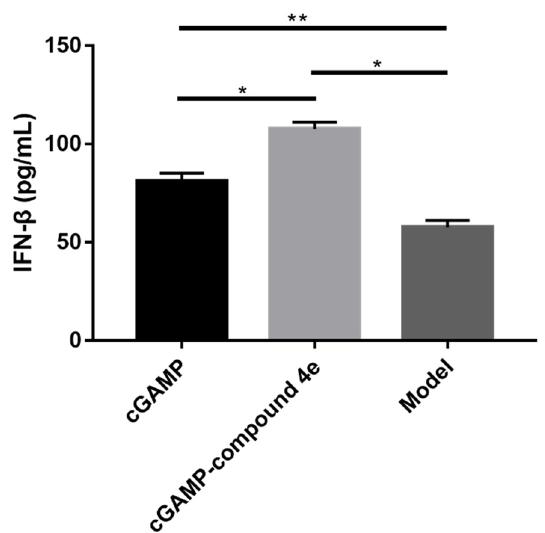
Figure 7. Pharmacodynamic profile of compound 4e in vivo. IFN- β in serum was measured by ELISA. The values are represented as mean ± SEM, n = 3; (*) p < 0.05 and (**) p <